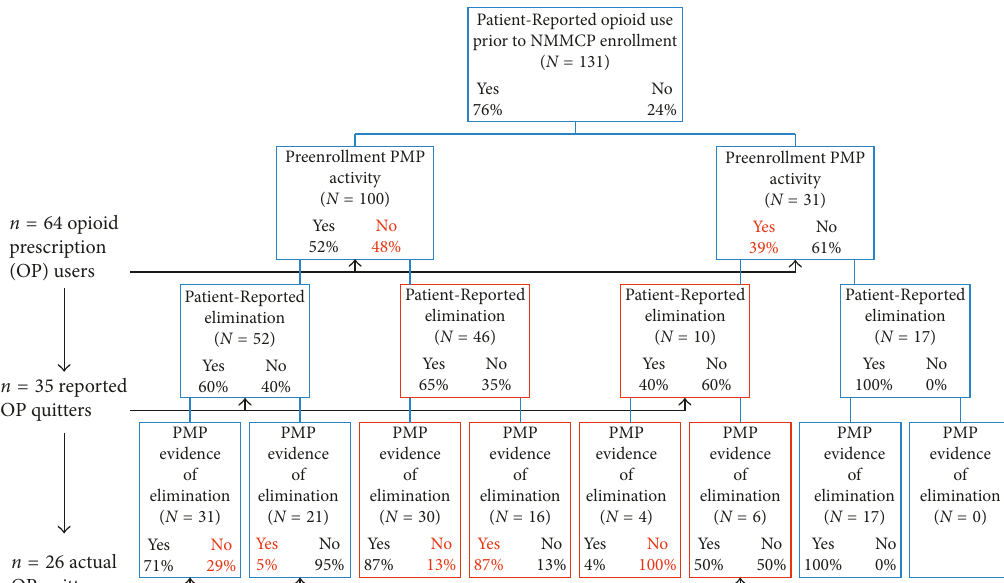
Figure 1: Diagram of patient-reported and PMP-recorded opioid prescriptions. The percentages refer to the proportion of that subsample ( N ) responding as specified. “Patient-reported” refers to patients’ queried responses at the time of NMMCP enrollment renewal; “PMP” refers to categorizations based on evidence in the PMP records. Patients were asked about preenrollment use. PMP records covering the six month period prior to enrollment were used to measure preenrollment PMP activity; PMP records for months 12 and 13 were used to evaluate elimination. Red-colored patient rates indicate misreporting; red outlines indicate repeated